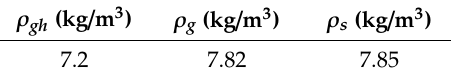
Table 1. Weight density of used